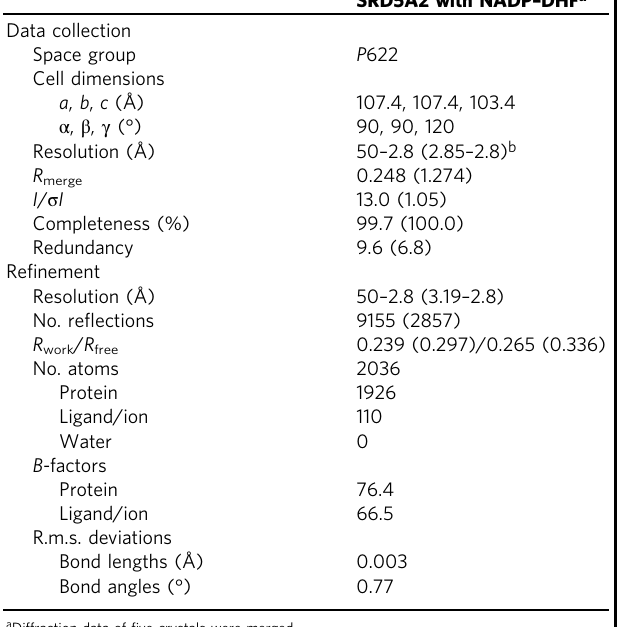
Table 1 X-ray data collection and re fi nement statistics (molecular